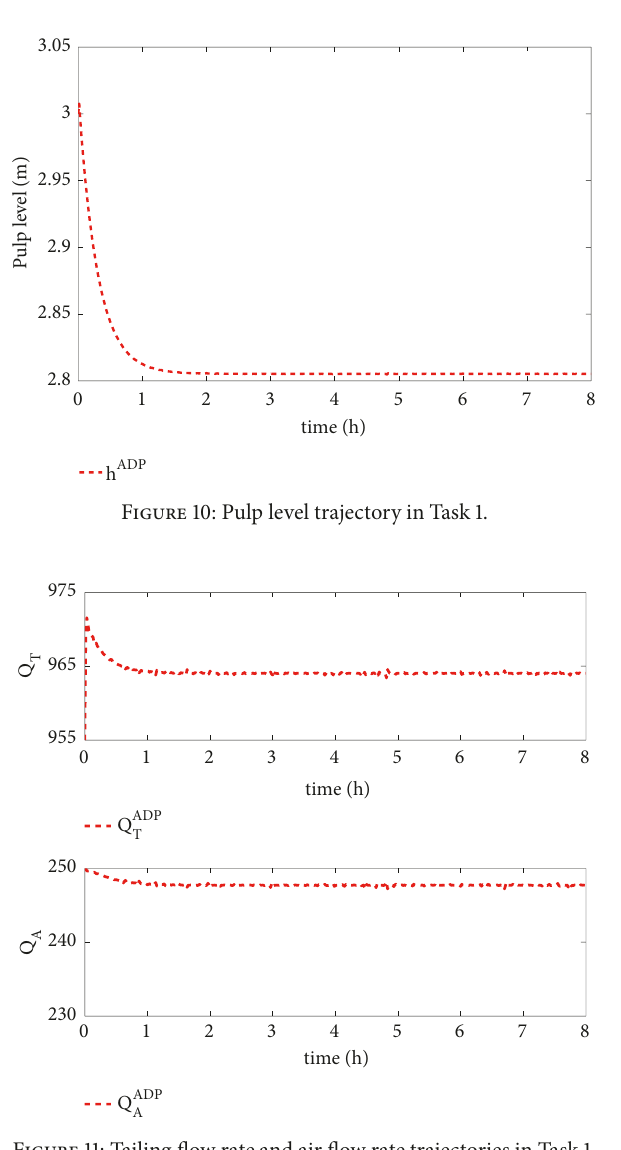
Figure 11: Tailing flow rate and air flow rate trajectories in Task 1.